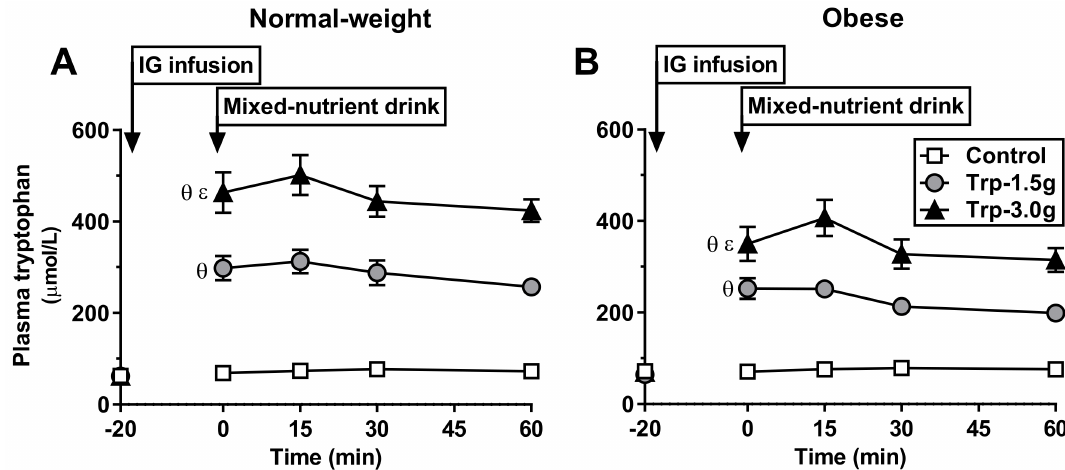
Figure 3. Plasma tryptophan concentrations at baseline ( t = − 20 min) and in response to an oral mixed-nutrient drink ( t = 0 min) following intragastric (IG) infusion of tryptophan, at doses of 1.5 g (‘Trp-1.5g’) or 3.0 g (‘Trp-3.0g’), or control, in healthy normal-weight ( A ) and obese ( B ) volunteers. Data are means ± SEM, n = 16. Changes from baseline at t = 0 min, and blood glucose and C-peptide concentrations at t = 30 min, were analyzed using repeated-measures ANOVA. Differences between treatments were assessed using paired t -tests, with adjustments for multiple comparisons made using Bonferroni’s correction. ( A ) At t = 0 min, the increase from baseline was markedly greater after Trp-3.0g compared with ( θ ) control and ( ε ) Trp-1.5g, and after Trp-1.5g compared with ( θ ) control ( P < 0.001 for all); ( B ) at t = 0 min, the increase from baseline was greater after Trp-3.0g, compared with ( θ ) control and ( ε ) Trp-1.5g, and after Trp-1.5g compared with ( θ ) control ( P < 0.001 for